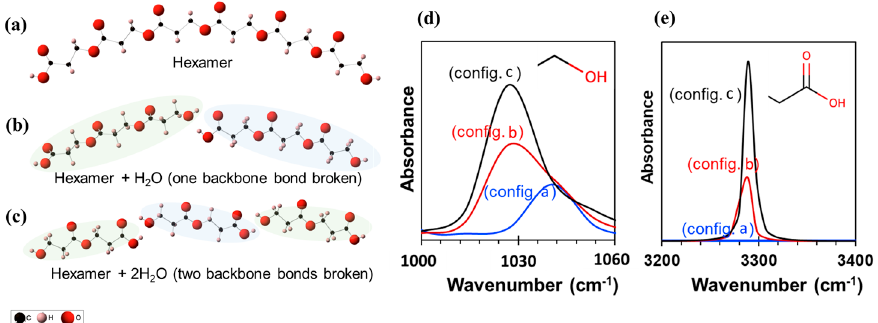
Figure 5. Three different chemical structures considered for the DFT calculations. ( a ) Hexamer, ( b ) two trimers with one H 2 O, and ( c ) three dimers with two H 2 O. Panels ( d ) and ( e ) show the infrared spectra for the three structures, zoomed into two different wavenumbers for the sake of clarity.